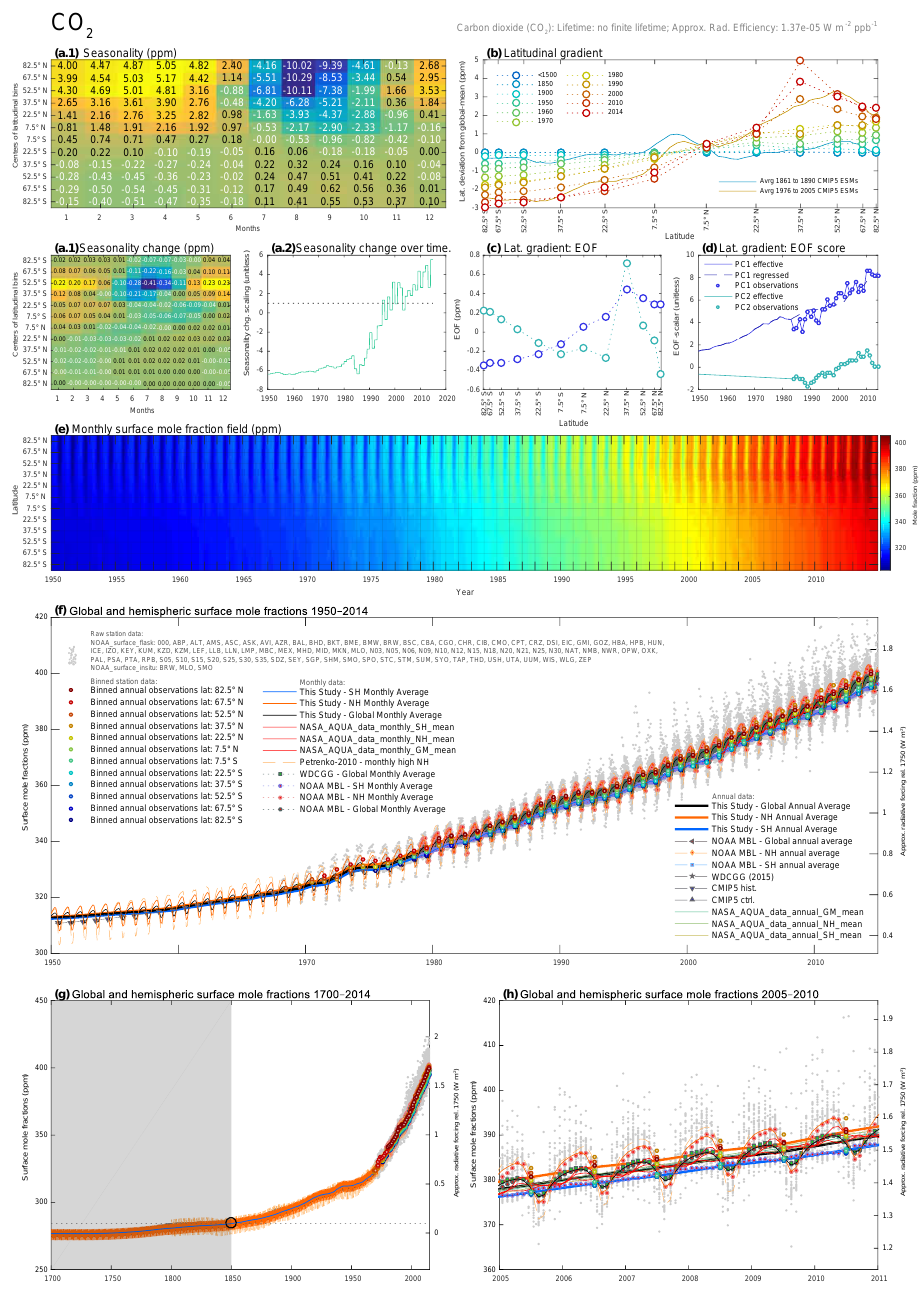
Figure 9. Overview of historical CO 2 concentrations. (a.1) The average seasonality of CO 2 over the observational period, (a.2) the change of seasonality over time. (a.3) The observationally derived and extended EOF score of the seasonality change. The first EOF1’s score is almost linearly increasing over the time of instrumental data from 1984 to 2014. (b) The latitudinal variation of mole fractions (dashed lines), shown for example years from 1500 to 2014, including (for comparison) the average of three CMIP5 ESMs (solid lines). (c) The first and second EOF of latitudinal variation. The second EOF exhibits a strong signal around mid-northern latitudes (d) , the EOF scores derived from the observational data (dots) and regression (dashed line) as well as the ultimately used EOF score (solid line). The second EOF’s score indicates that the mid-latitude northern spike was only a recent phenomenon and the score is here assumed to linearly converge to zero. The first EOF’s score is more linearly increasing, and regressed against global fossil emissions. (e) The resulting latitudinal-monthly concentration field, here shown between 1950 and 2014. (f) Global and hemispheric means of the derived concentration field over the same time period 1950–2014 in comparison to monthly station data (grey dots), latitudinal average station data (coloured circles) and various literature studies (see legend). (g) Same as (f) , except for time period 1750–2014. (h) Same as (f) but for time period